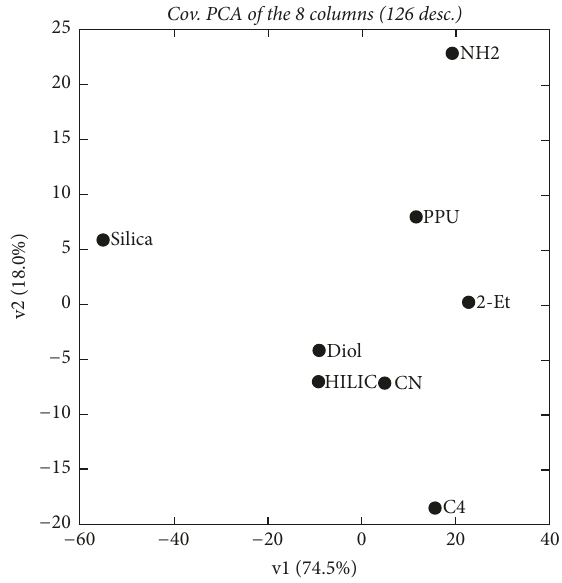
Figure 3: Score plot generated by PCA for the 8 × 126 matrix (8 columns described by 14 drugs in the 9 experimental